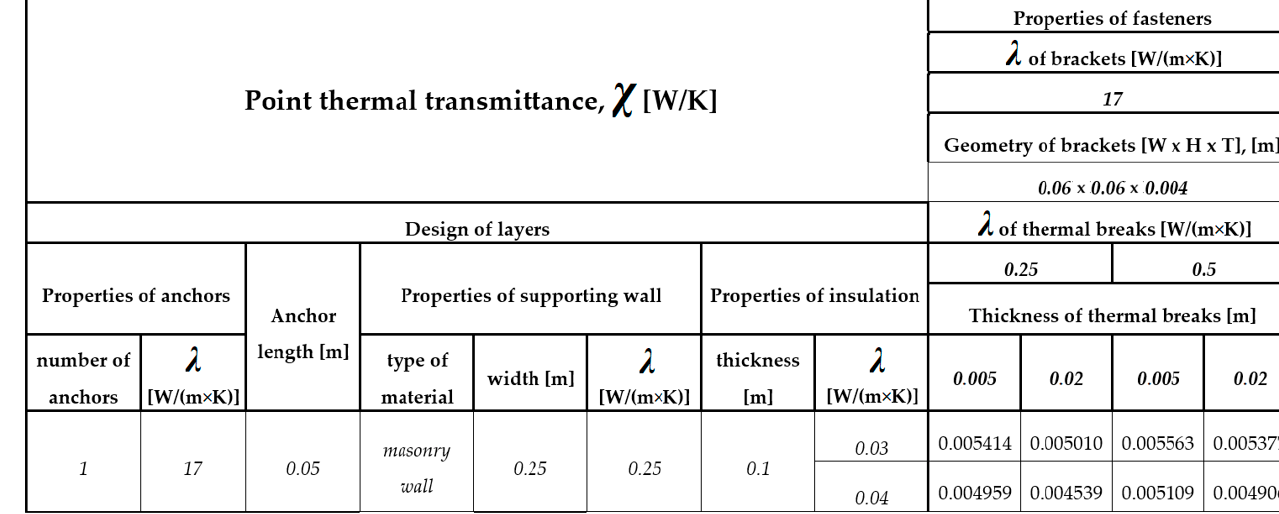
Figure 10. Thermal bridge catalogue (extract).